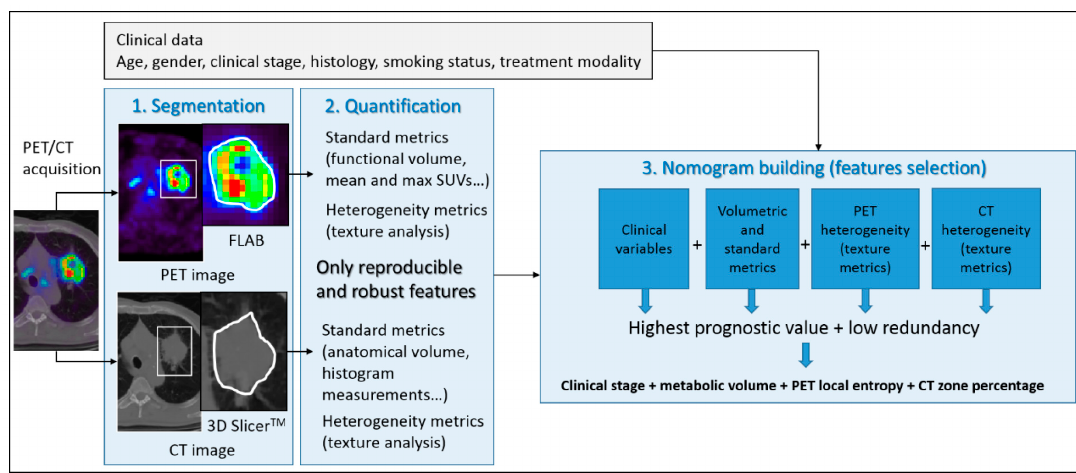
Figure 5. Workflow of a nomogram construction combining tumor and heterogeneity features extracted from both PET and CT components of routinely acquired FDG-PET scans in non-small cell lung cancers, allowing for better stratification among patients with stage II–III, compared to stage I. This research was originally published in EJNMMI [104]. © Springer.